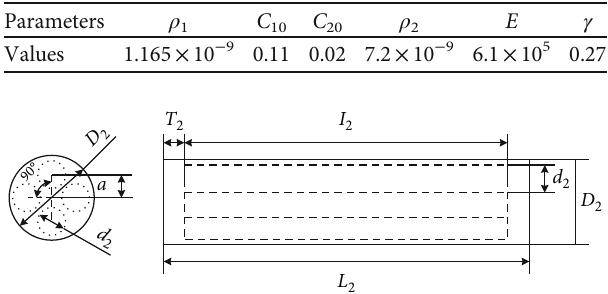
T ABLE 2: The parameters of simulation conditions.